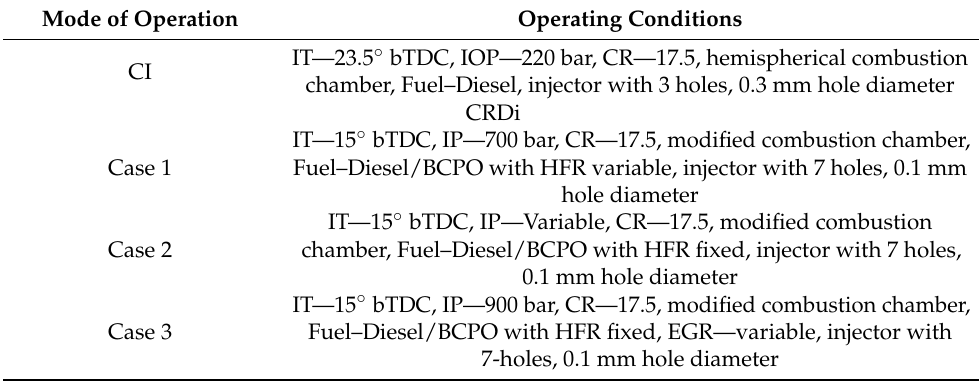
Table 4. Operating conditions in CI and CRDi